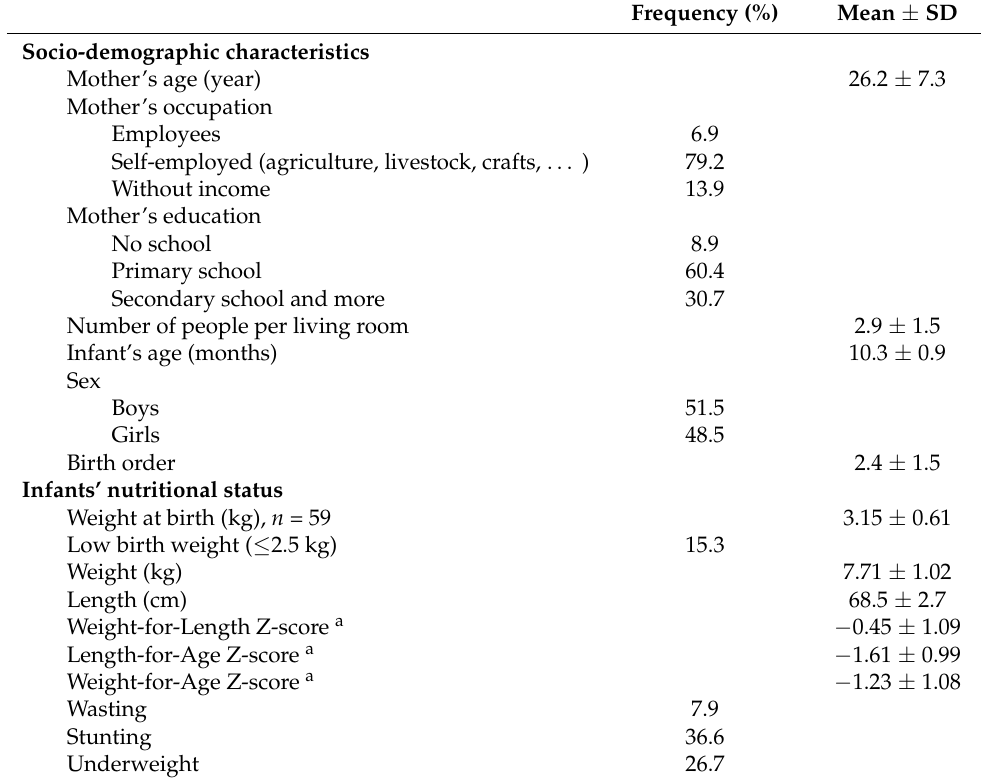
Table 1. Main characteristics of households, caregivers and children ( n =